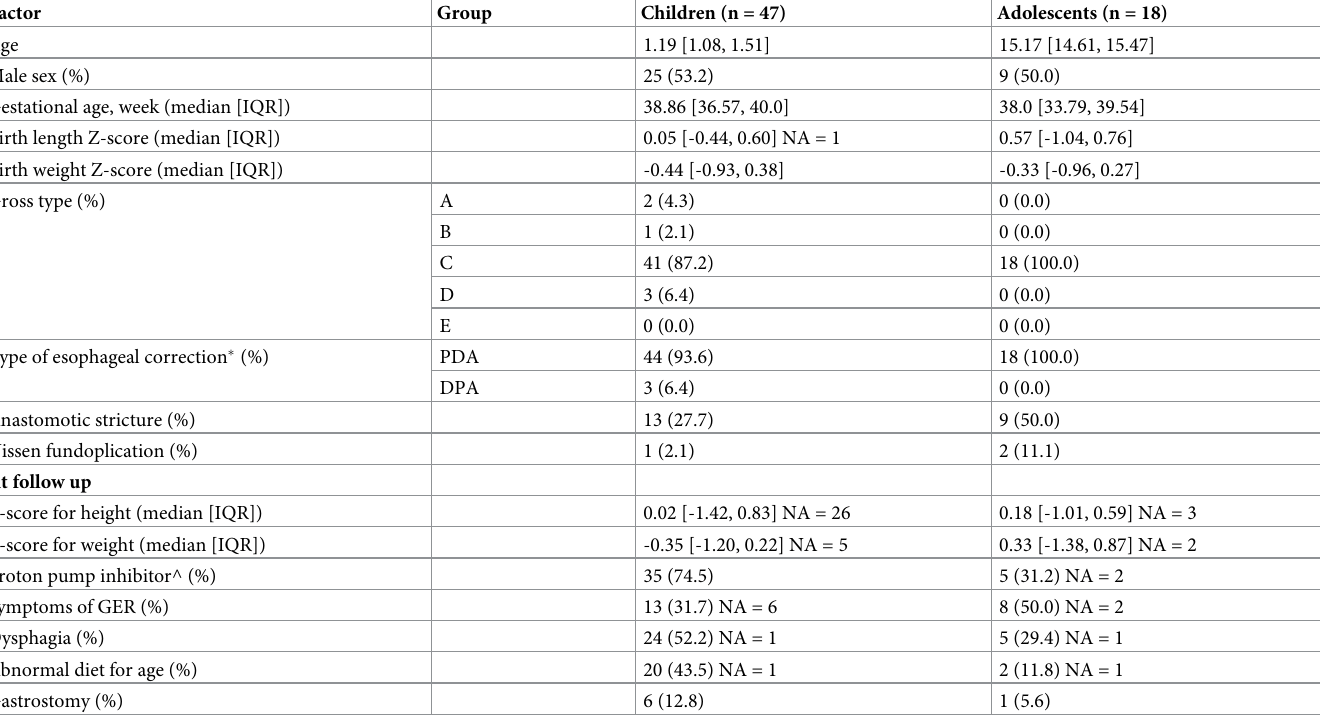
Table 1. Patient demographics by age